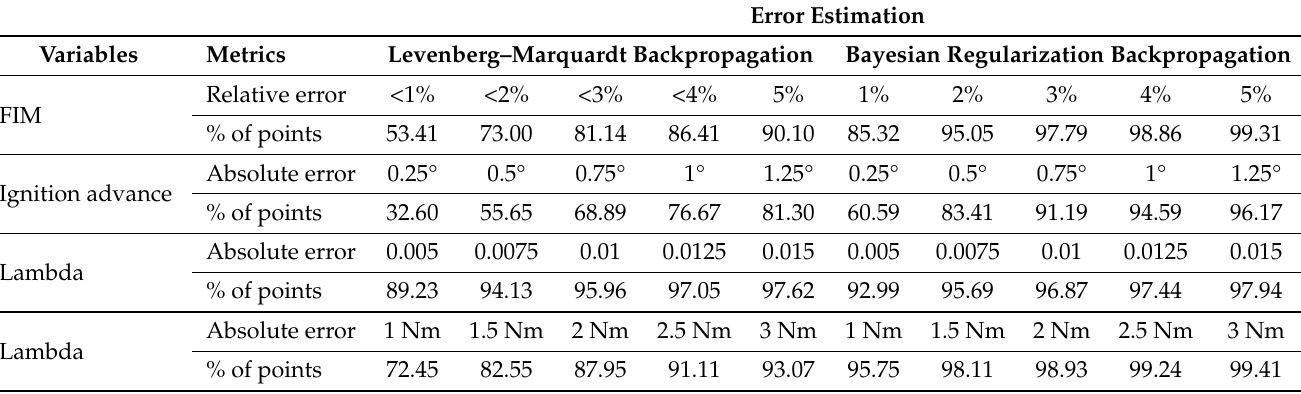
Table 7. Precision of ANN trained with 65% of